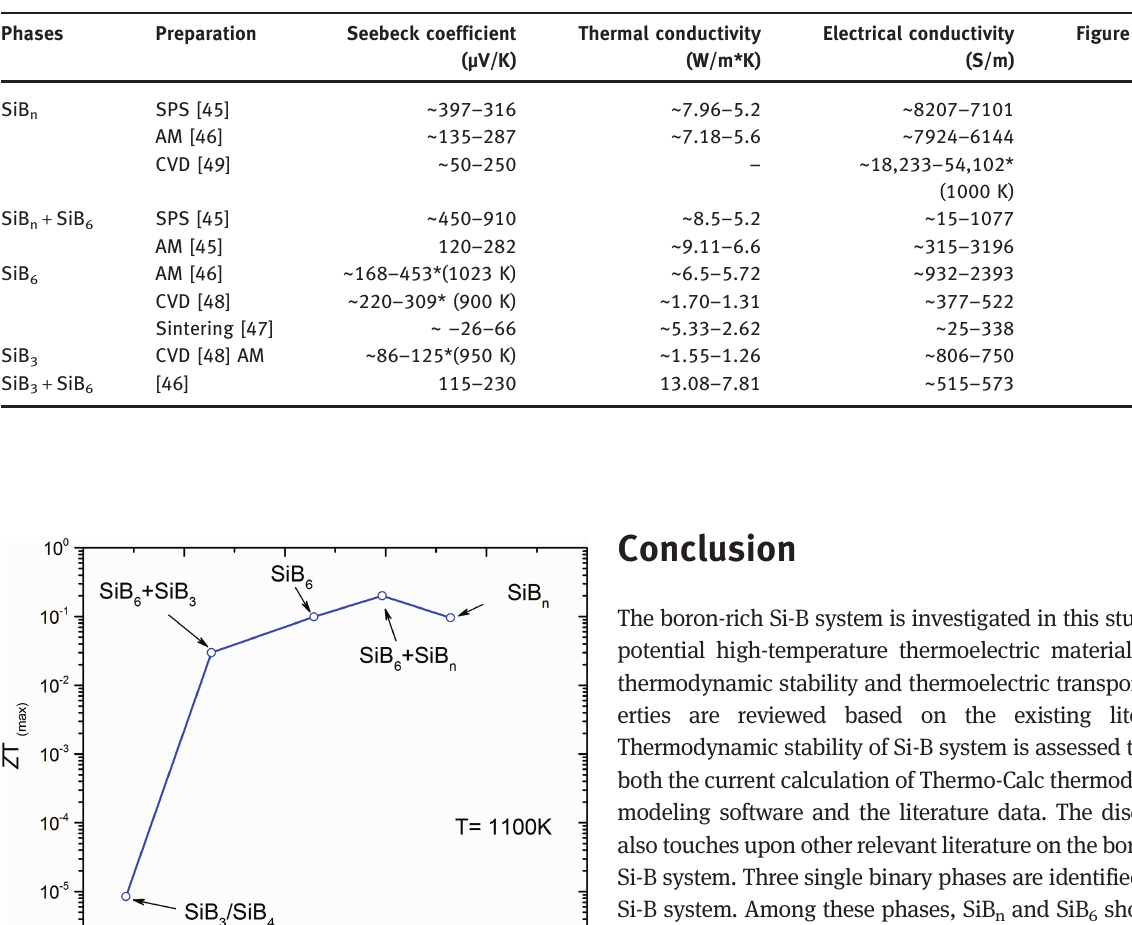
Table 4: Summary of the thermoelectric properties of Si-B system in the temperature range around 500 – 1100 K (* different temperature